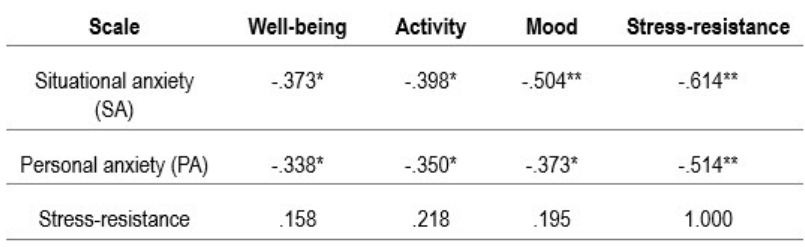
The results of the correlation analysis of anxiety and stress resistance specifics in Chinese students